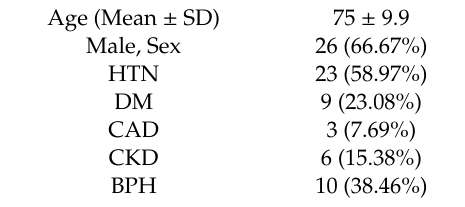
Table 1. Demographics of normal pressure hydrocephalus patients ( n =